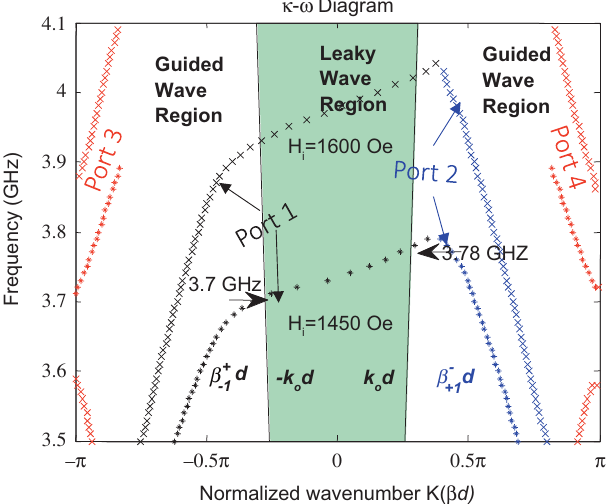
Figure 3. Dispersion diagram of the coupled microstrip lines unit- cell in Figure 2. Calculations refer to H i = 1450 Oe (indicated with *) and 1600 Oe (indicated with ·